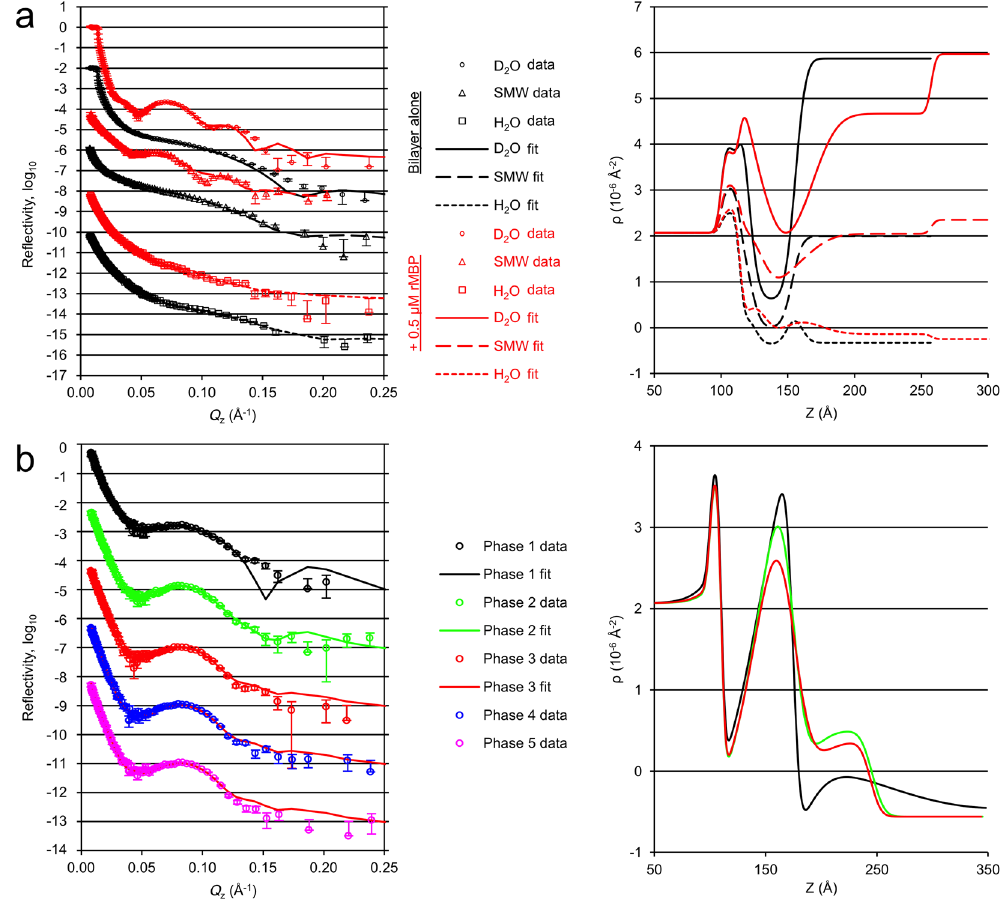
Figure 5. Accumulation of rMBP onto lipid bilayers. Data and fits are plotted on the left and scattering length density ( ρ ) profiles on the right. All reflectivity curves have been offset for clarity. ( a ) Steady-state NR experiment of DMPC:DMPG lipid bilayers with and without rMBP at different solvent contrasts. ( b ) Time- resolved NR experiment. The phases represent 15-min time-slices of rMBP associating with a d 54 -DMPC:d 54 - DMPG bilayer in an H 2 O contrast. The fitting curve for phase 3 has also been overlaid with phases 4 and 5, demonstrating steady state. The error bars represent standard